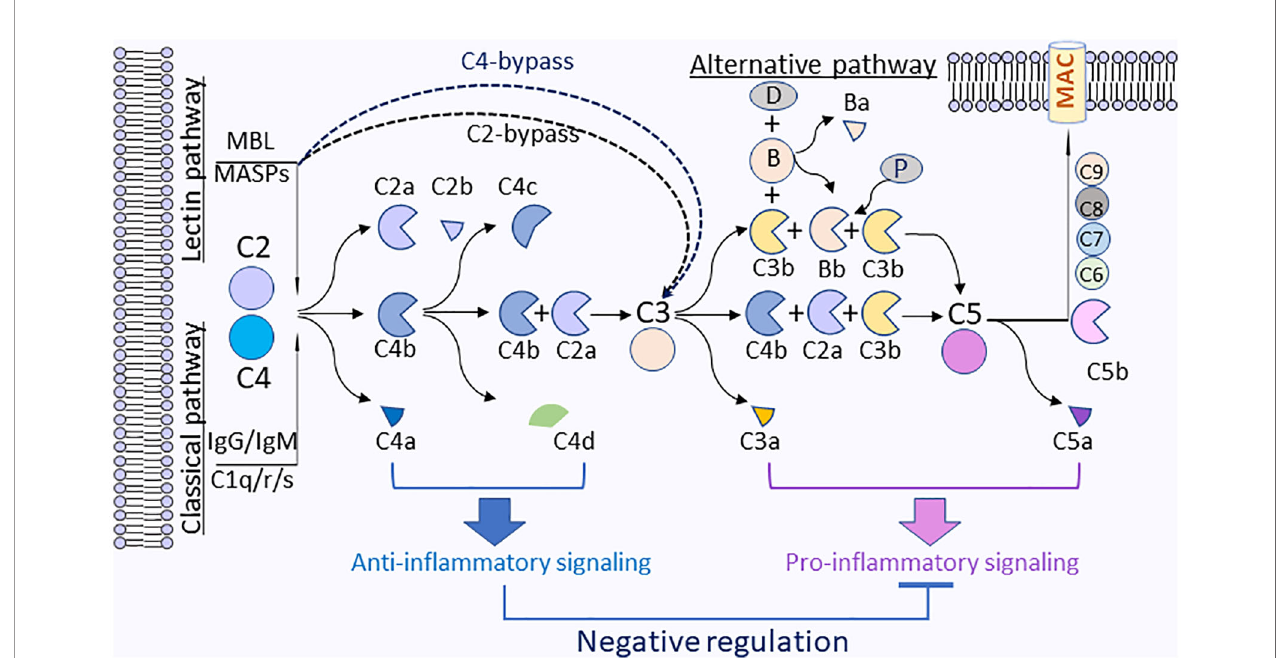
FIGURE 3 | Anti-in fl ammatory functions by complement C4 activation fragments C4a and C4d. On the surface of pathogens, the activation of complement C4 is triggered through classical (antibody) or lectin (sugar) pathways that will activate C1s or MAPSs, which will rapidly cleave C4 to generate C4a and C4b. C4b will be further fragmented by factor I and cofactors to generate C4d and C4c. C4b will associate with C2a to form a complement C3 cleavage enzyme (C3 convertase), C4b2a, which will cleave C3 to generate C3a and C3b. C3b will be associated with C4b2a to converge to C5 convertase (C4bC2aC3b), which will cleave C5 to generate C5a and C5b. C5b will associate with C6, C7, C8, and C9 to form membrane attack complexes (MAC) C5b-9 on the surface of pathogens. For the alternative pathway, C3b is spontaneous C3 turnover or generated by classical or lectin pathways. C3b bound to factor B (B). The complex is converted by factor D (D) to C3-cleaving enzyme C3bBb that is stabilized by properdin (P) and further form C3bBbC3b, which can cleave C5 to generate C5a and C5b. Plasma membrane (blue) represents the surface of pathogen